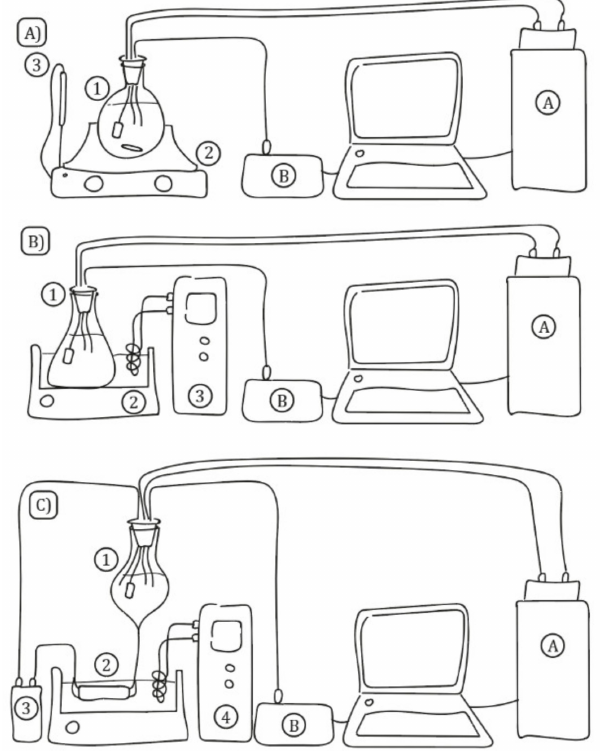
Figure 1. Laboratory systems. ( A ) Non-sonicated extractions at different temperatures (1: extraction cell, 2: heating plate and 3: thermocouple); ( B ) non-pumped sonicated extractions at different power densities (1: extraction cell, 2: ultrasound bath and 3: temperature controller); and ( C ) pumped sonicated extractions at different power densities (1: glass tank, 2: extraction cell, 3: pump and 4: temperature controller). In all diagrams: A: spectrophotometer and B: temperature